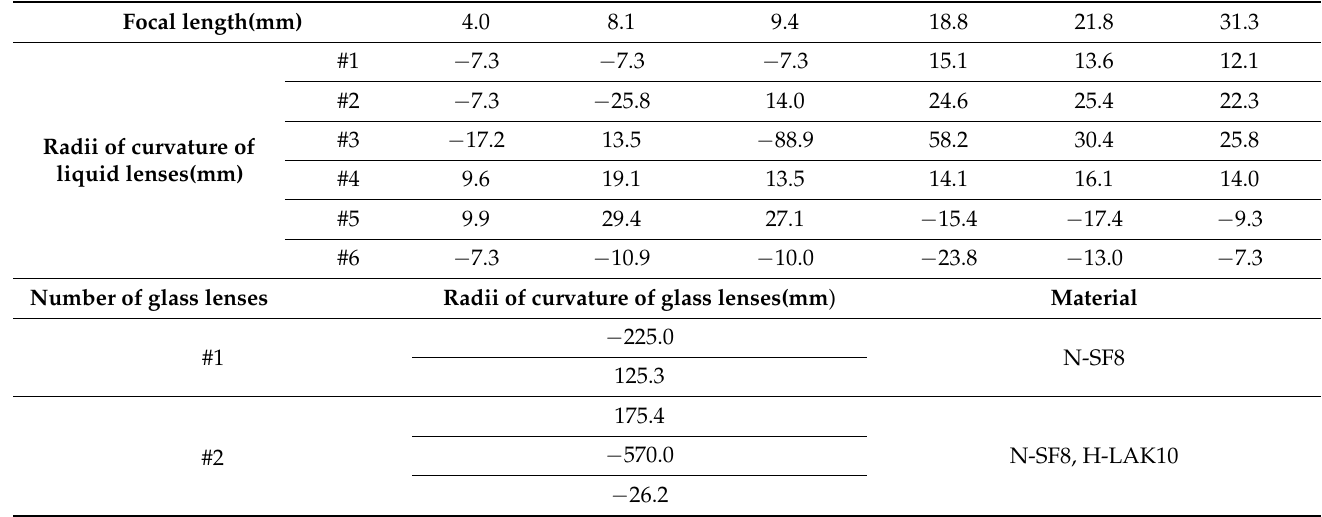
Table 1. Radii of curvature of liquid lenses and glass lenses at different focal lengths and the materials of glass